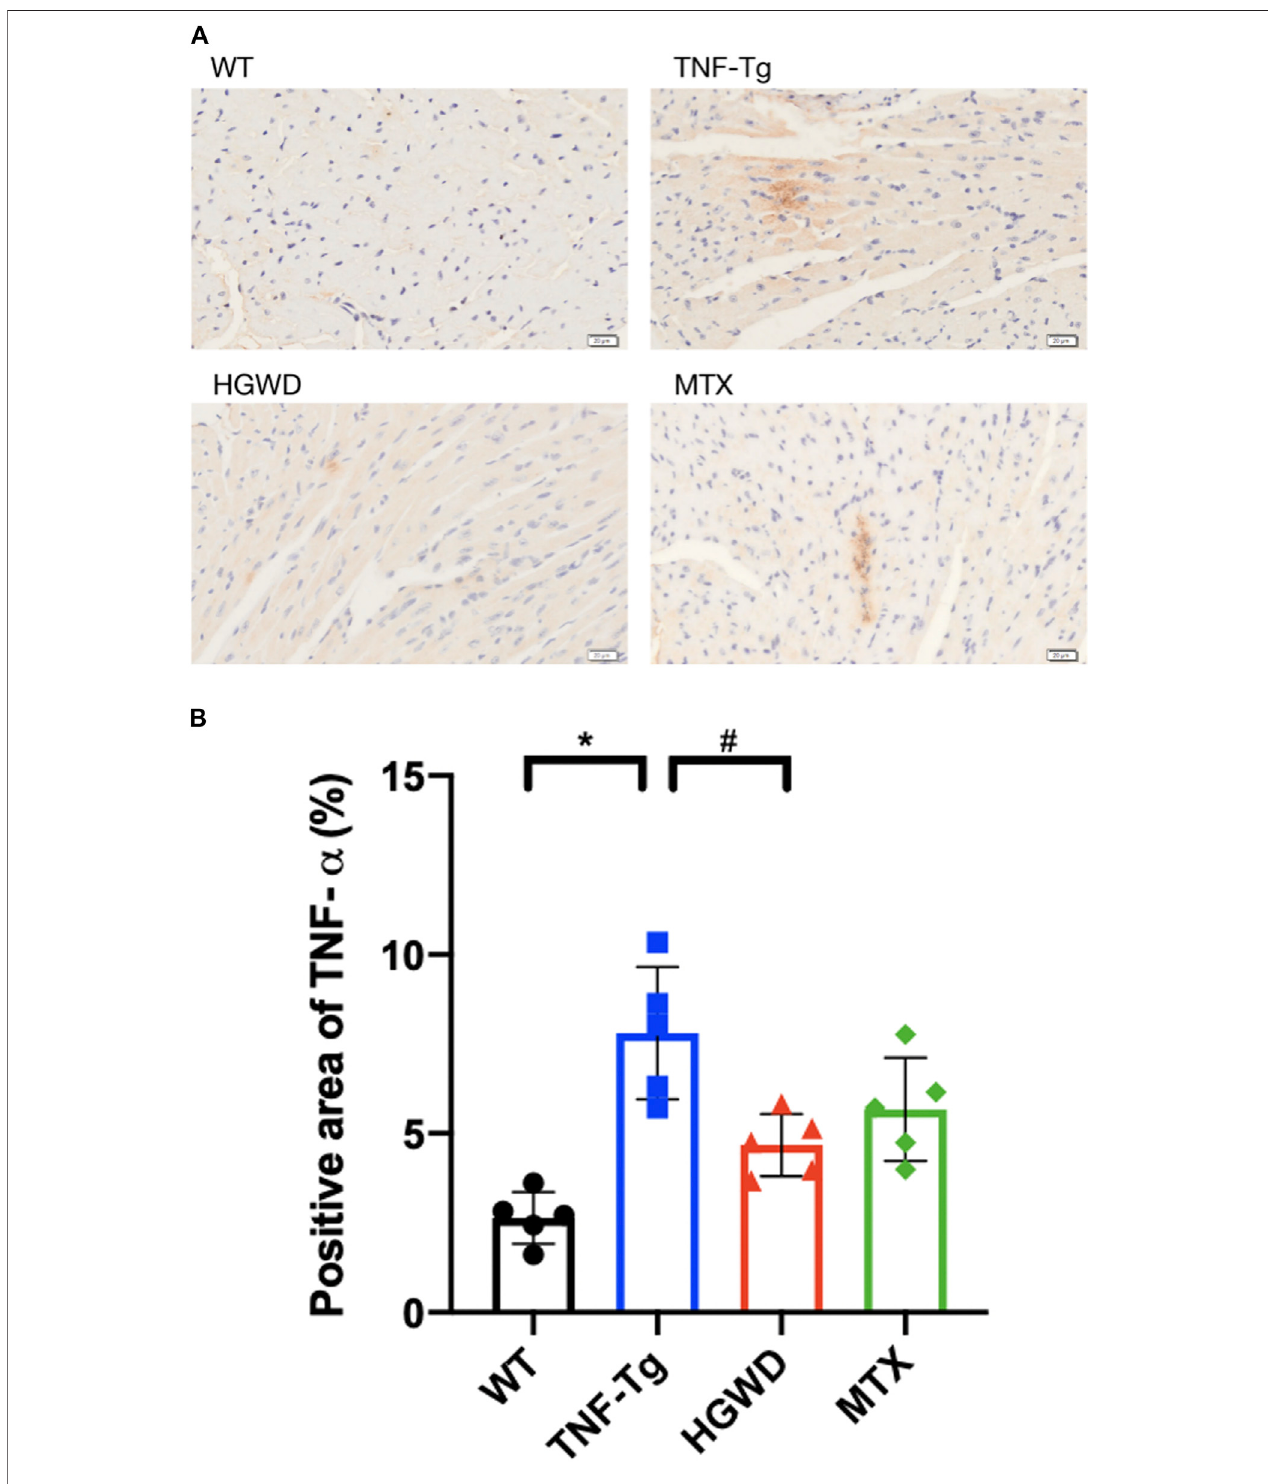
FIGURE 5 | HGWD reduces the expression of TNF- α in myocardial tissue of TNF-Tg mice. (A) Representative mice heart immunohistochemical staining sections showed that the expression of TNF- α in TNF-Tg mice was increased, and after treatment, it was lower than that in the TNF-Tg group. Bar = 20 μ m. (B) Quanti fi cation of the positive area of TNF- α . Values are the mean plus or minus SD of 5 hearts in each group. * p < 0.05, compared with WT group; # p < 0.05, compared with TNF- Tg group.